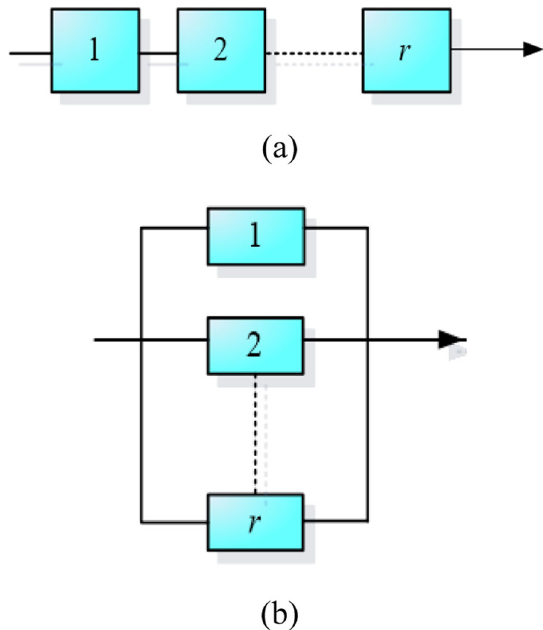
Fig. 4 Block diagram of a Series system b Parallel